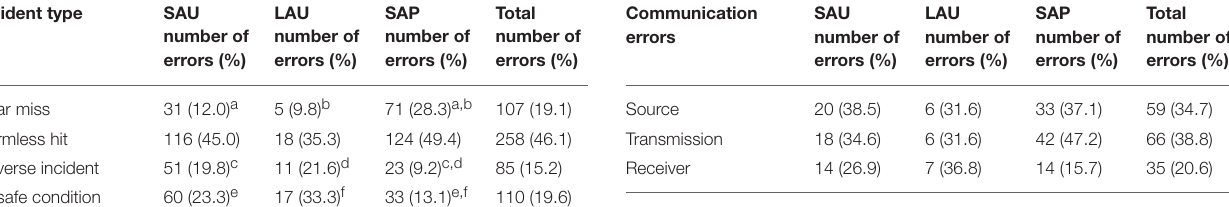
TABLE 4 | Distribution of incident types at each hospital (see Figure 1 for hospital abbreviations). Incident type